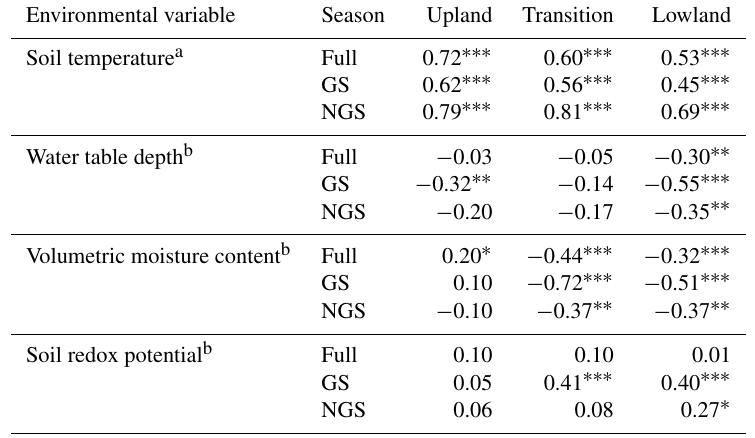
Table 2. Regression analysis ( r ) results of potential environmental variables that predict CO 2 emissions along a moisture